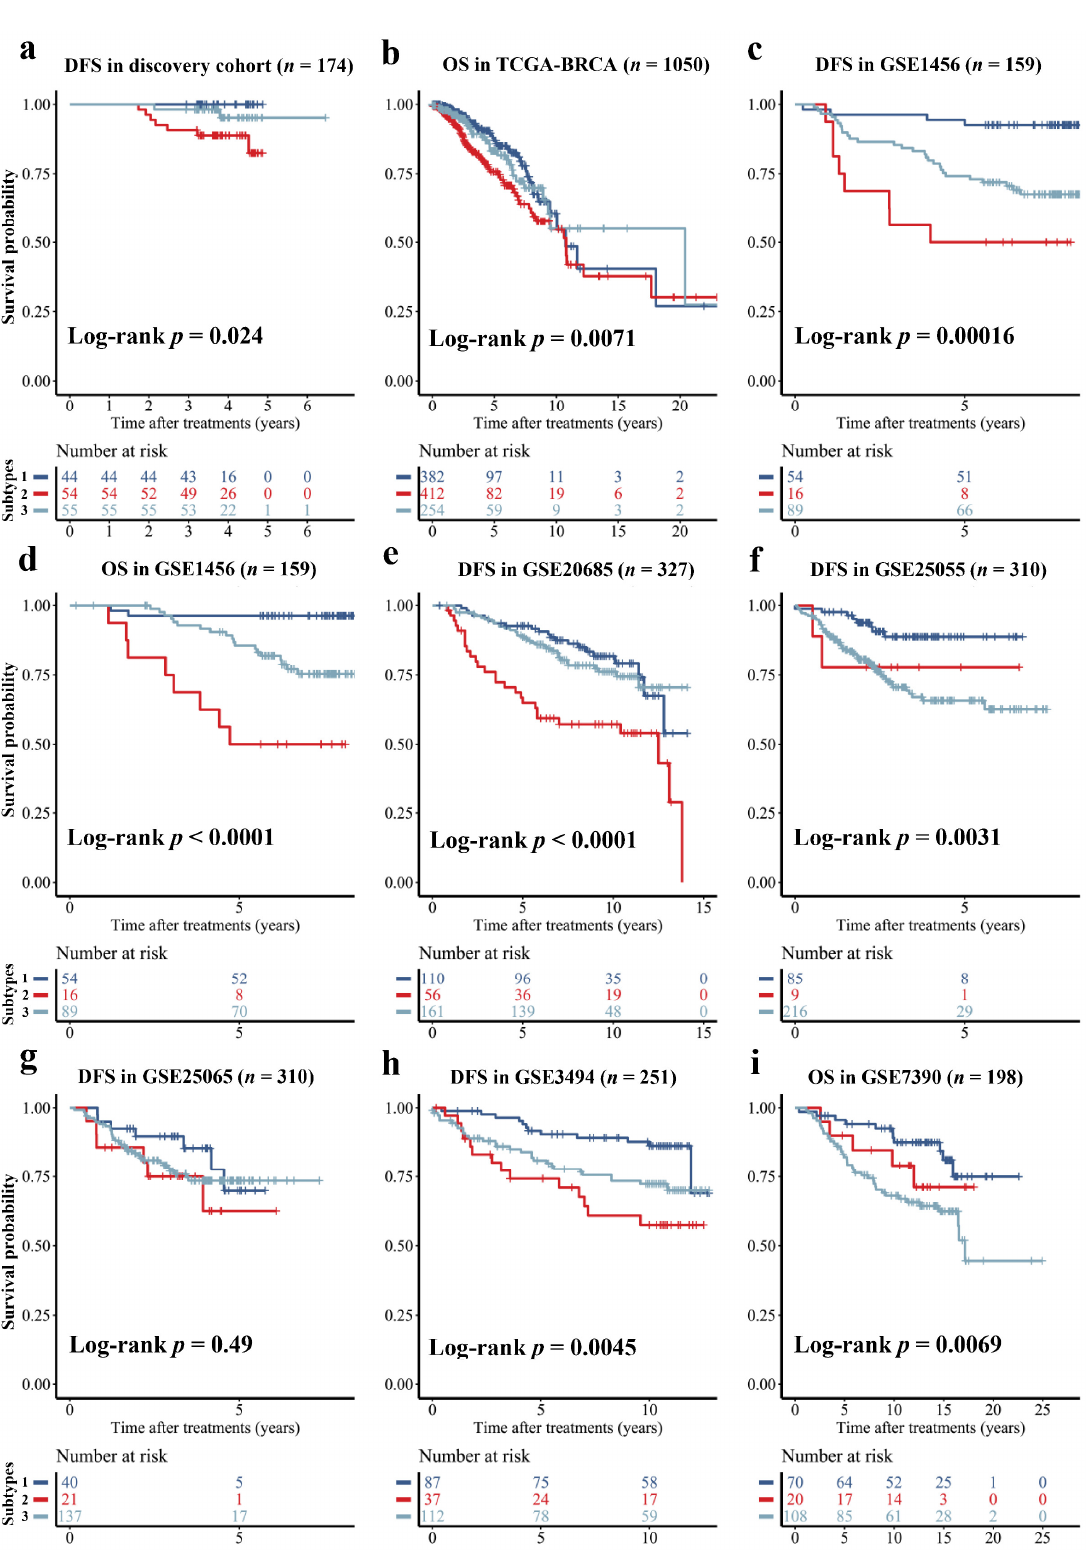
Figure 4. Prognosis of DFS or OS stratified by the DCE-MRI subtypes. The Kaplan-Meier curve was plotted for the stratified samples by three imaging subtypes in the discovery cohort ( a ), and evaluated in seven external datasets without imaging data but by using a gene-profile-based imaging subtypes classifier to determine the imaging subtypes ( b – i